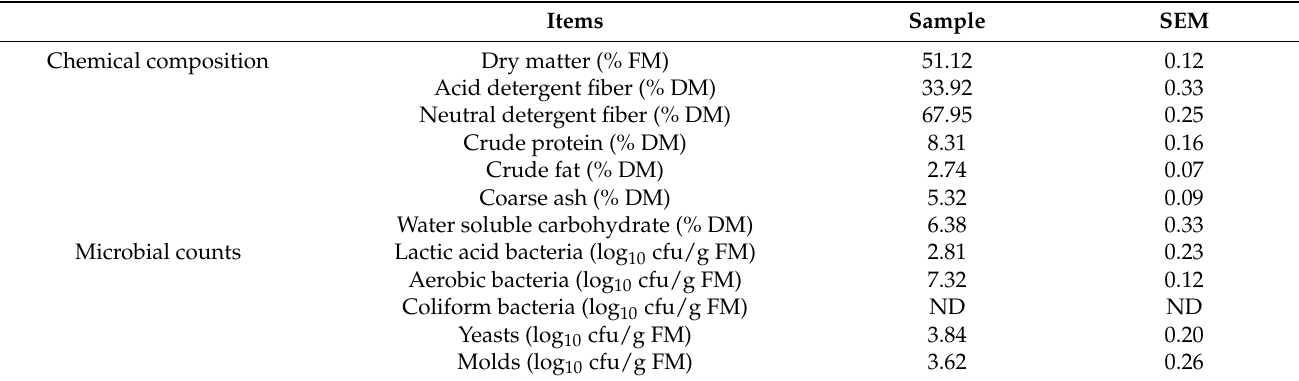
Table 1. Chemical and microbial compositions of fresh native